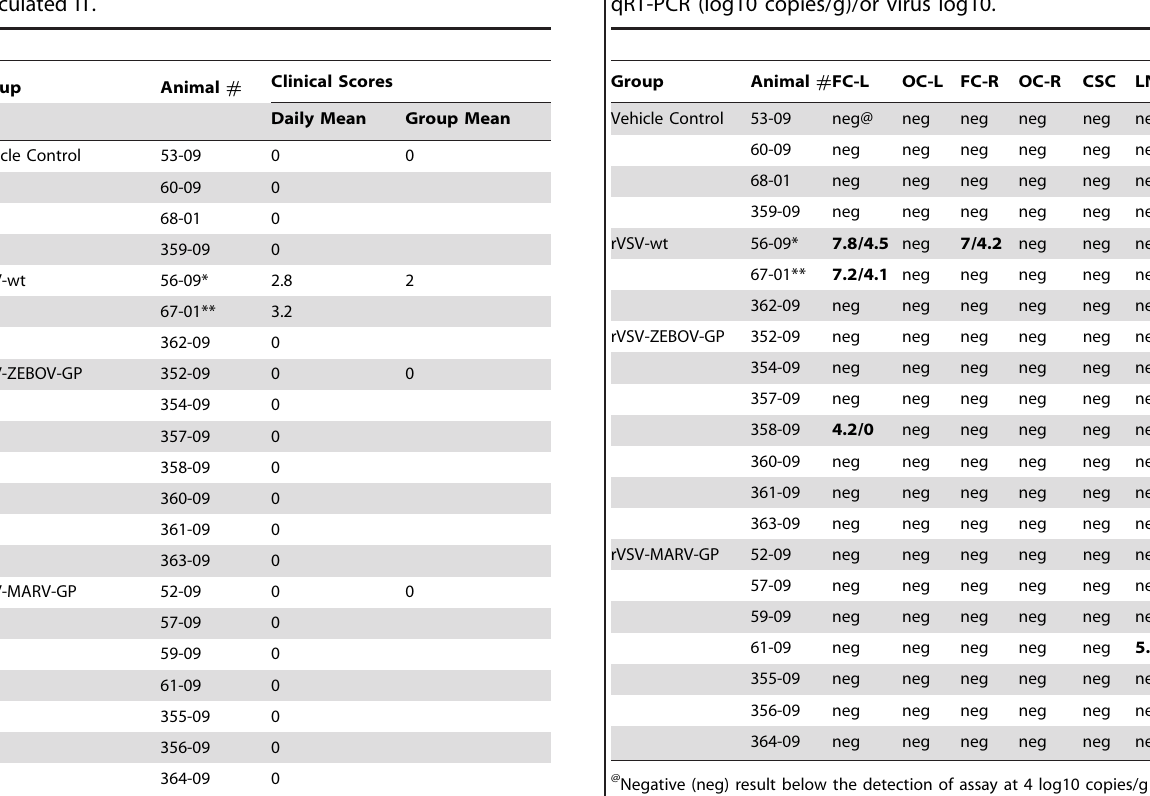
Table 1. Daily and group mean neurologic scores of animals inoculated IT.